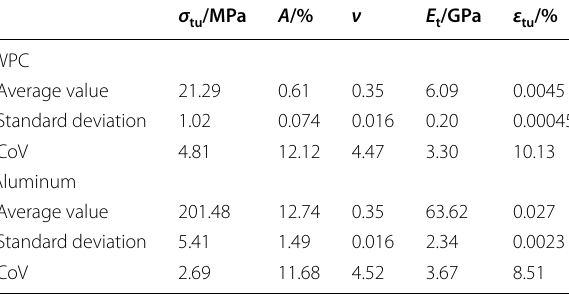
Table 1 Mechanical parameters of WPC and aluminum